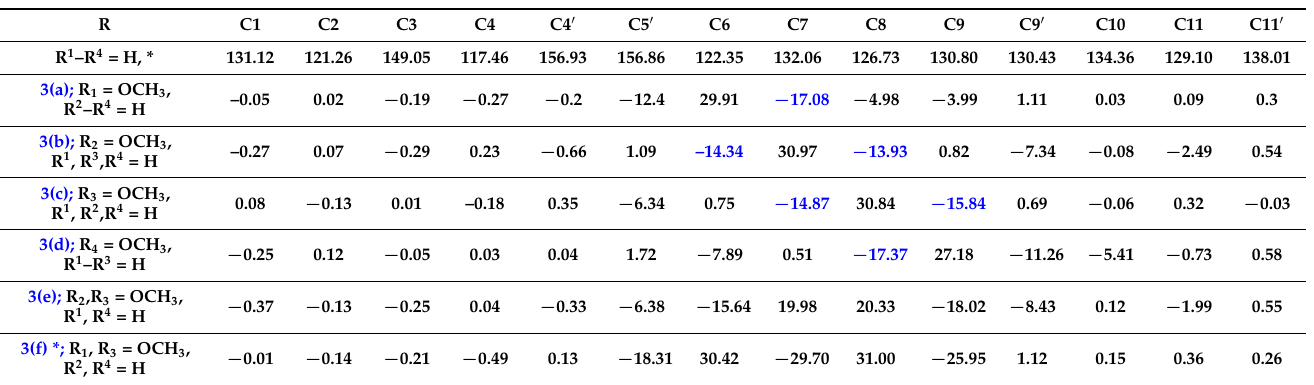
Table 3. Carbon-13 chemical shifts for 3-nitrodibenzo[ b , f] oxepine, substituent-induced chemical shifts for its methoxy substituted derivatives.